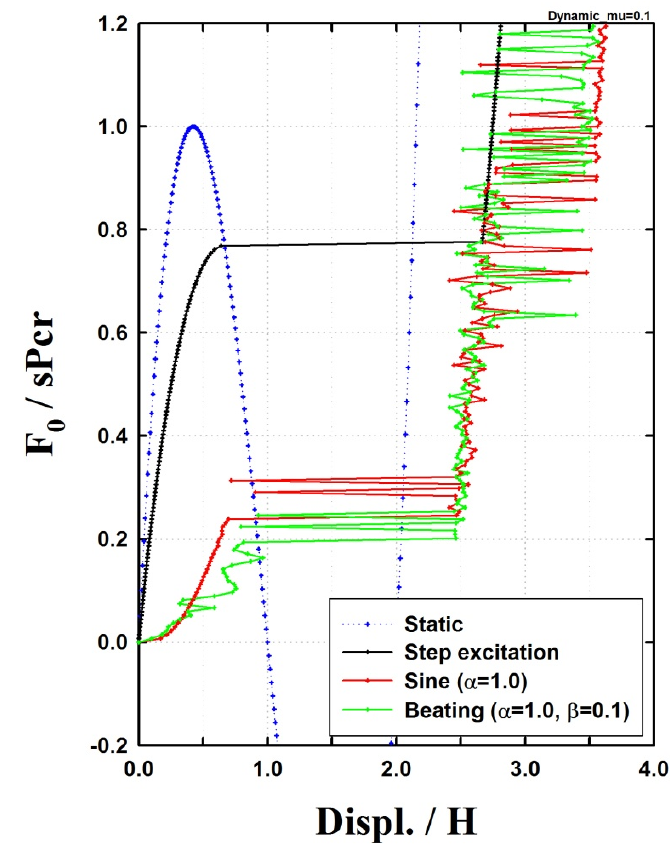
Figure 9. Maximum displacement response under various excitations ( μ (cid:3404) 0.1